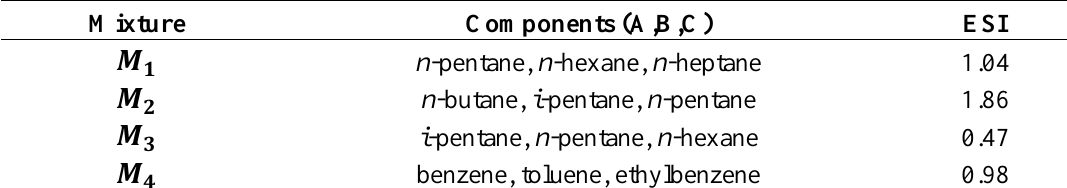
Table 1. Ternary mixtures considered in this